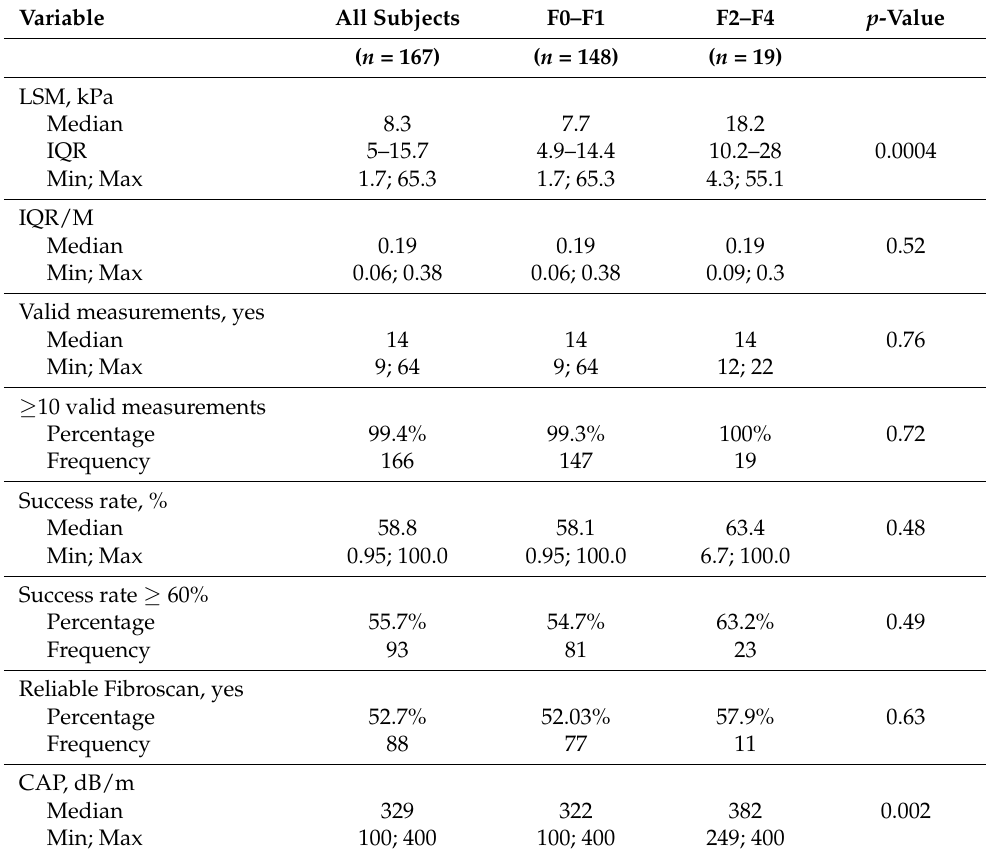
Table 3. Transient elastography features of enrollee subjects who underwent bariatric surgery at our institution between July 2017 and November 2019 ( n =